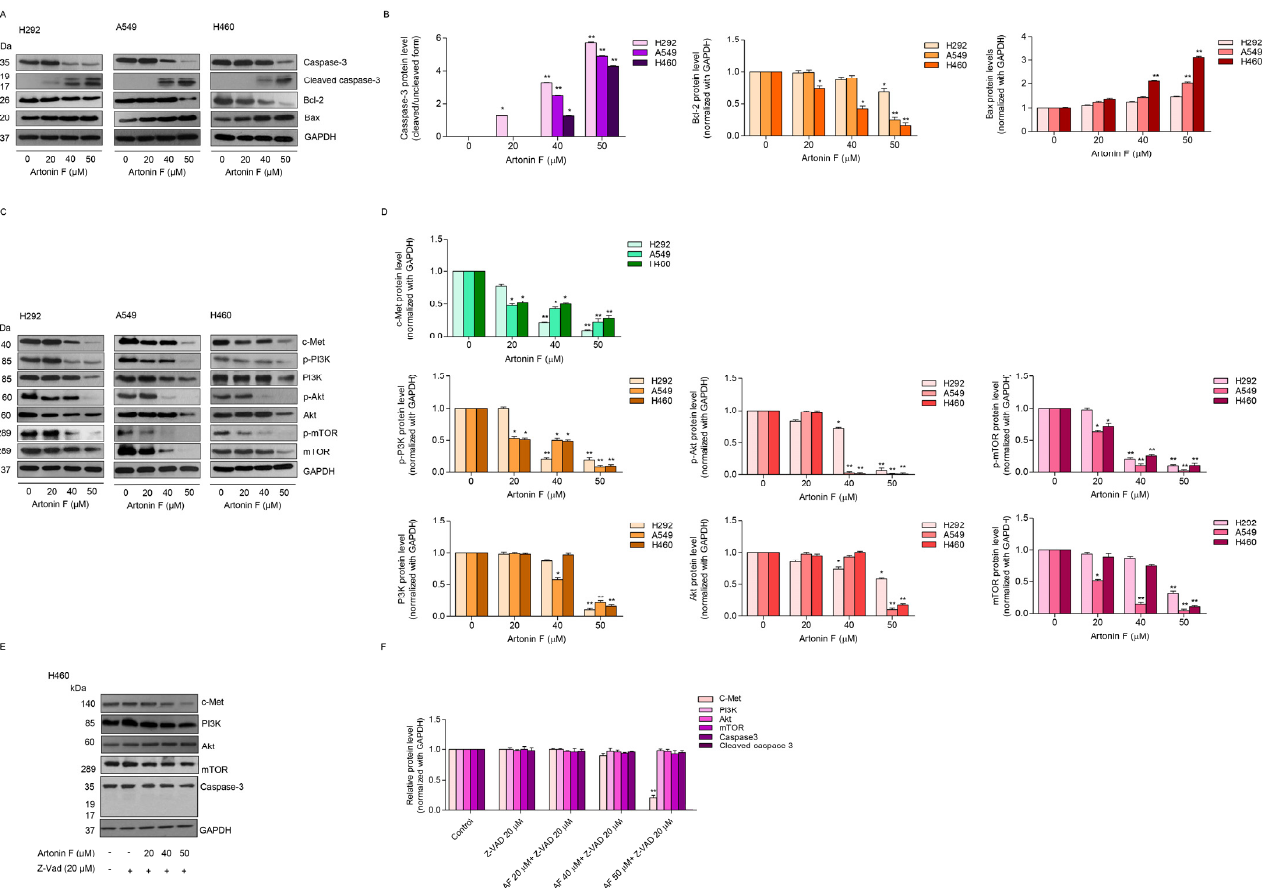
Figure 2. Artonin F triggers apoptosis through decreased c-Met and PI3K/Akt/mTOR signaling in lung cancer cells. ( A , B ) Effects of artonin F on the protein expression of the apoptosis-related proteins were detected by Western blot. Blots were reprobed with GAPDH to confirm equal loading of samples. The relative protein levels were calculated by densitometry. ( C , D ) Effect of artonin F on the protein expression of the c-Met/PI3K/Akt/mTOR marker was detected by Western blot. Blots were reprobed with GAPDH to confirm the equal loading of samples. ( E , F ) H460 cells were treated with artonin F and Z-VAD-FMK (20 µ M) for 24 h. Expression of the proteins was detected by Western blot. Blots were reprobed with GAPDH to confirm the equal loading of samples. The relative protein levels were calculated by densitometry. Data are shown as the mean ± SEM ( n = 3). * p < 0.05, ** p < 0.01 versus non-treated